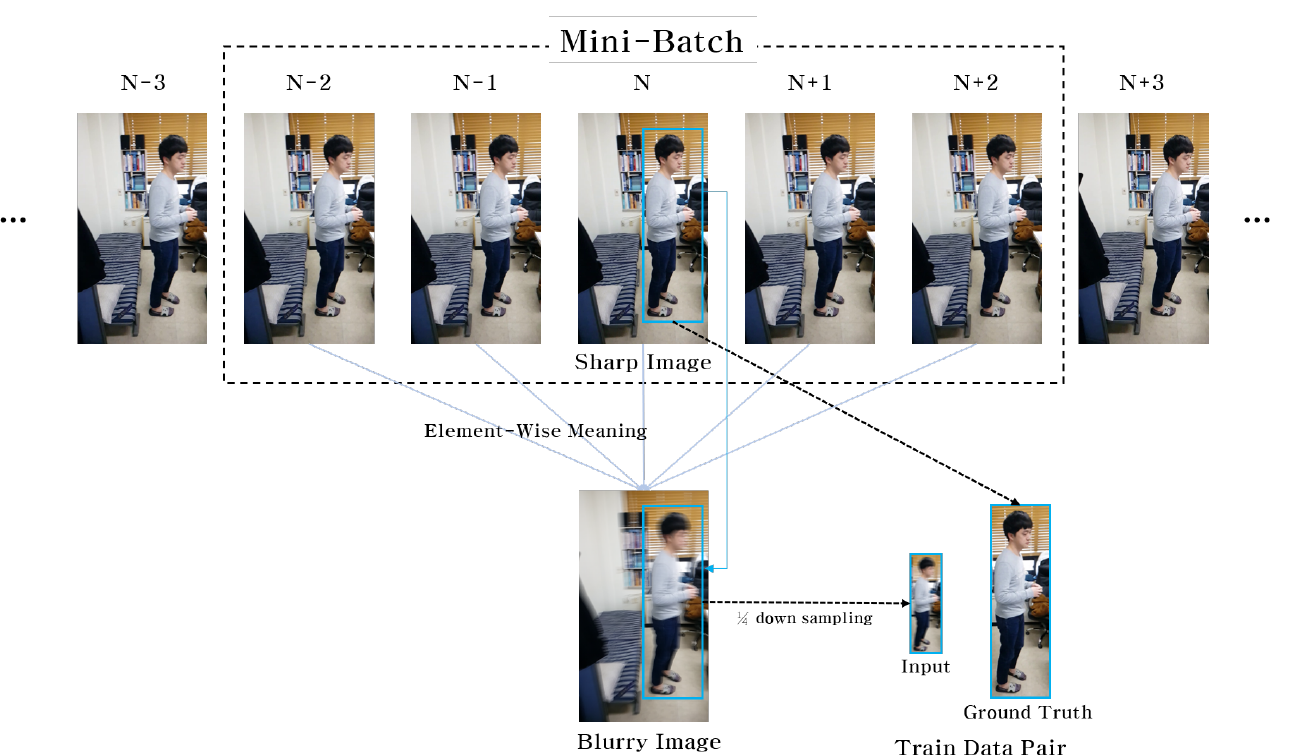
Figure 5. The construction of a training data pair for the image restoration